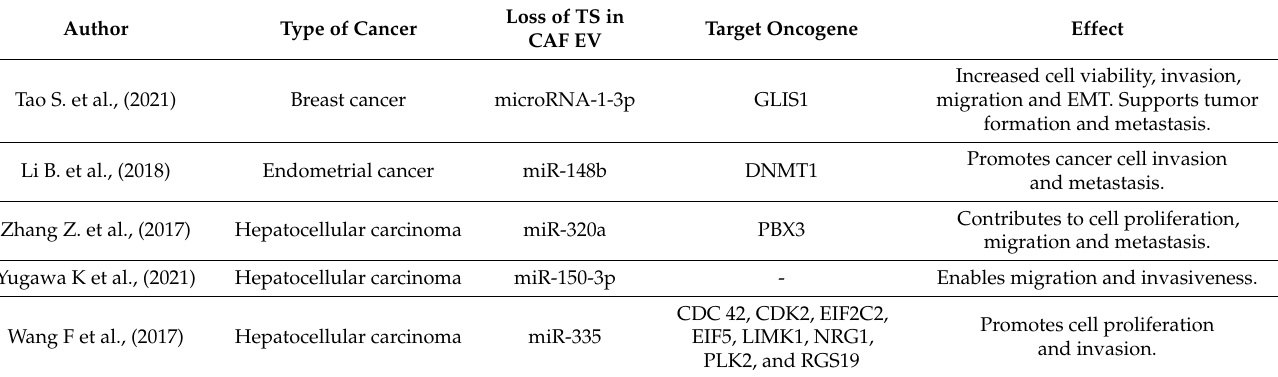
Table 2. Loss of tumor suppressor cargo in extracellular vesicles derived from cancer-associated fibroblasts and their effect on cancer